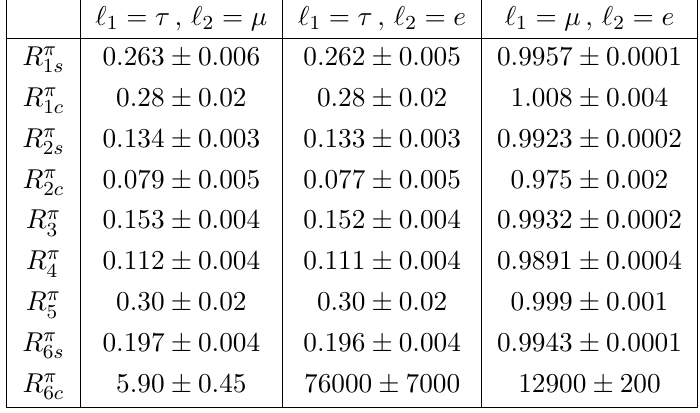
Table 2 . SM predictions for the ratios in eq. (6.15) using